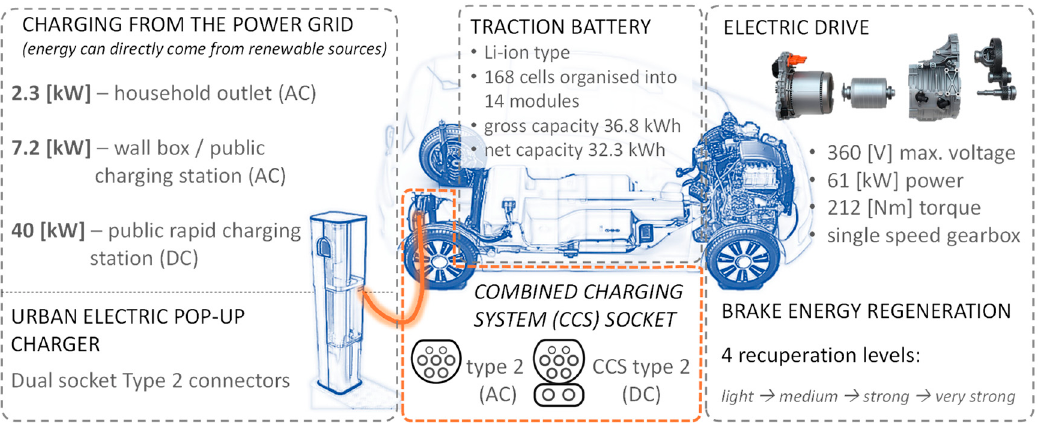
Figure 4. Basic parameters of the tested EV (own work on the basis of [43,44]).